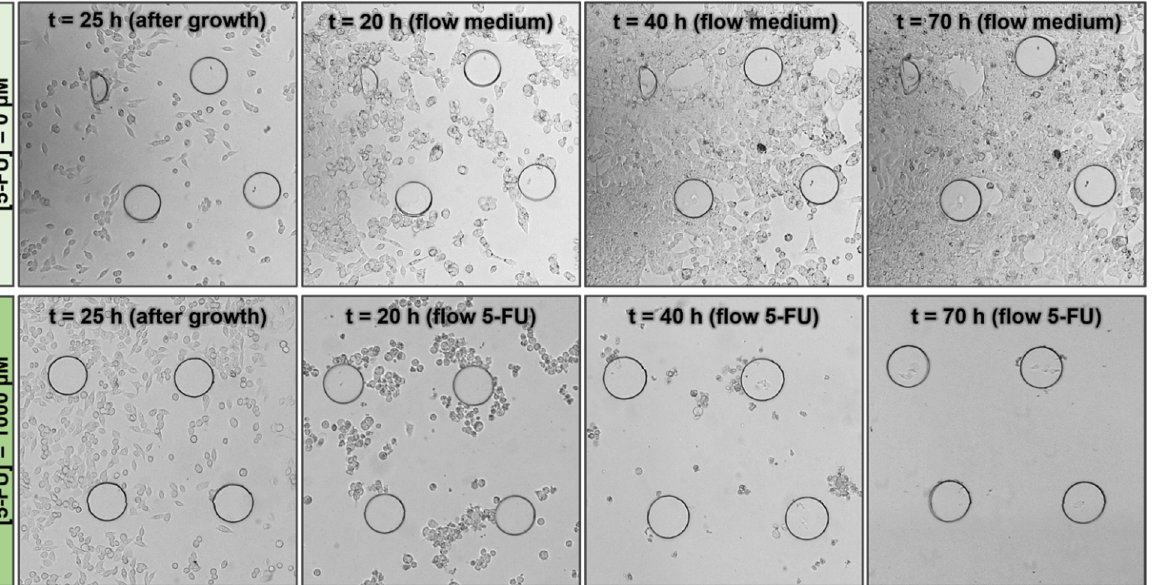
chamber. Figure S2. Optimisation performed related to blocking agent, using AK = 0 µ M (absence) and anti-AK antibody = 1